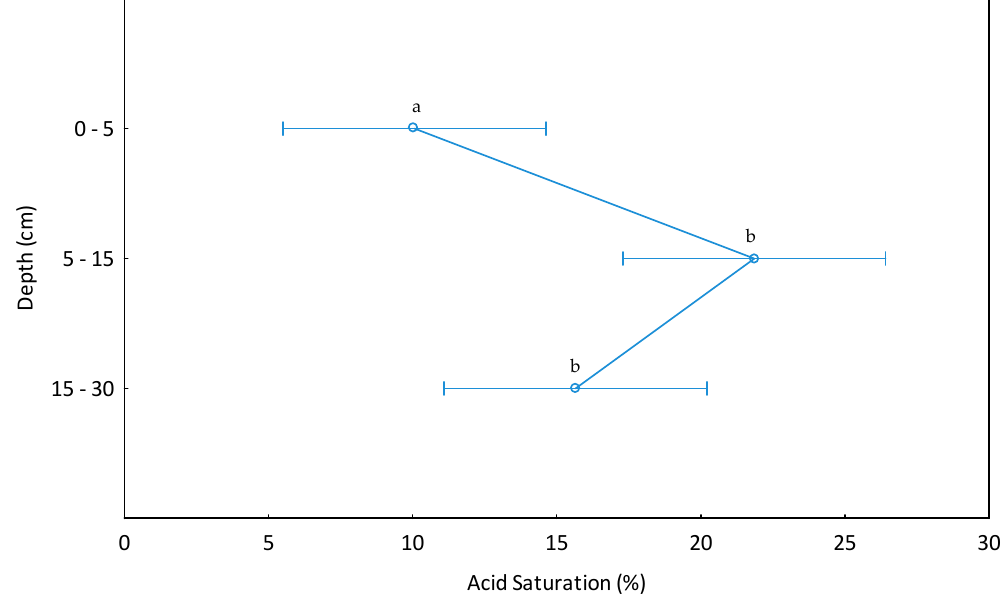
Figure 4. Stratification of acid saturation between 0–5, 5–15, and 15–30 cm soil depths of soils where at least one depth increment had pH (KCl) ≤ 5.0. No common superscript letter indicates a significant ( p ≤ 0.05) difference.